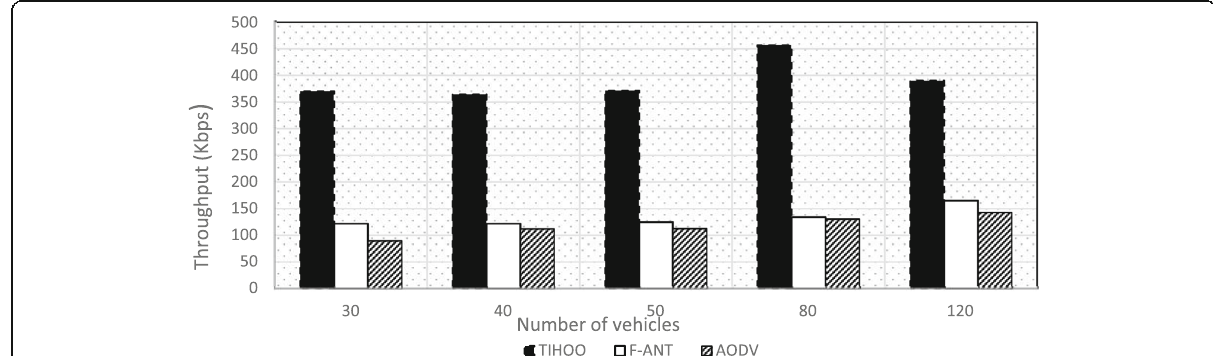
Fig. 8 Throughput based on number of vehicles. Comparison of the performance of TIHOO with that of F-ANT and AODV for throughput. Based on simulation figures, TIHOO has outperformed the other two protocols. Selecting the best route takes more time in F-ANT as it employs ACO and is slow to converge while the application of CS algorithm to TIHOO has brought about faster convergence and less parametric configuration demands during the implementation phase compared to other metaheuristic algorithms which have accelerated the selection of the optimal route and improved the throughput of the proposed